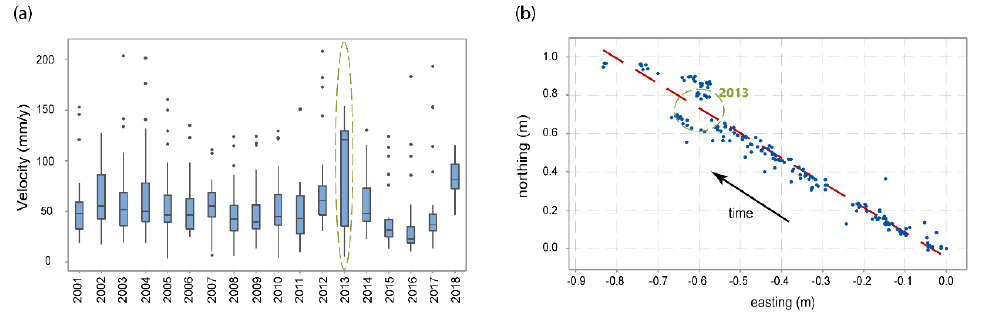
Figure 5. ( a ) Boxplots of the average annual horizontal displacement velocity of 26 geodetical observation points for 18 years. ( b ) Plan view of the evolution of the horizontal movement from 2001 to 2018, with the respective trendline for observation point PI3.